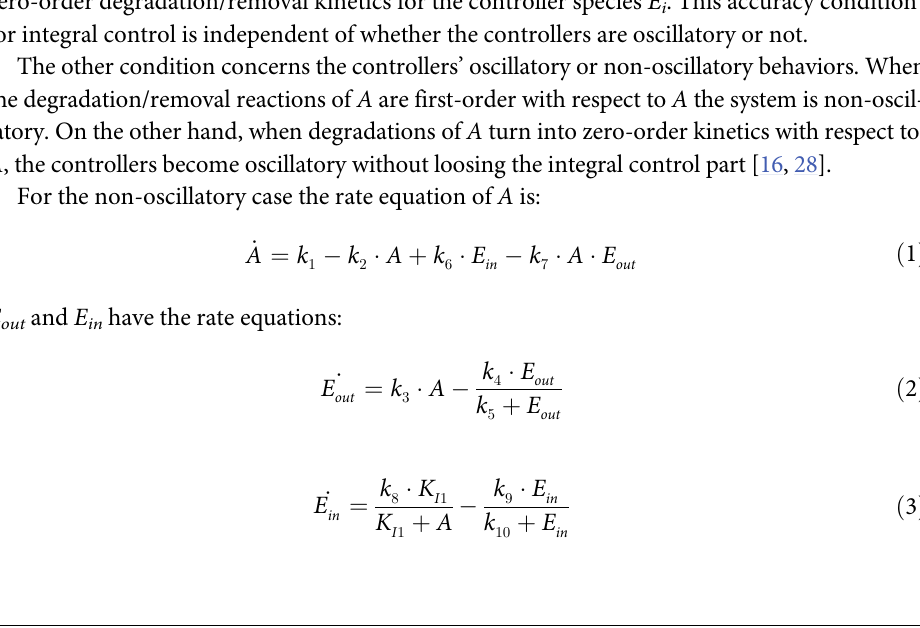
Fig 2. Combination of inflow/outflow controllers (indicated by the transporters E set-points, independent of the perturbation parameters k 1 and k 2 .